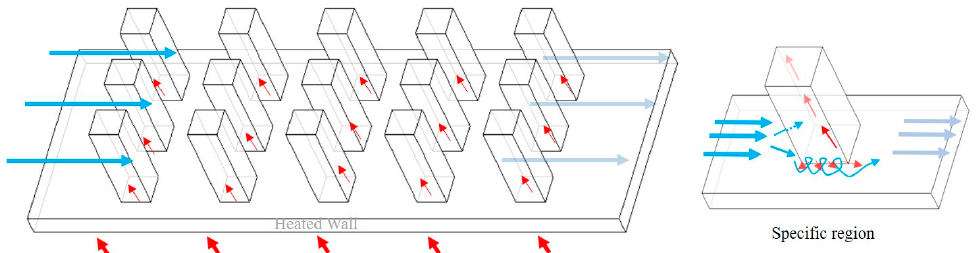
Figure 7. Schematic diagram of heat exchange from pin fin